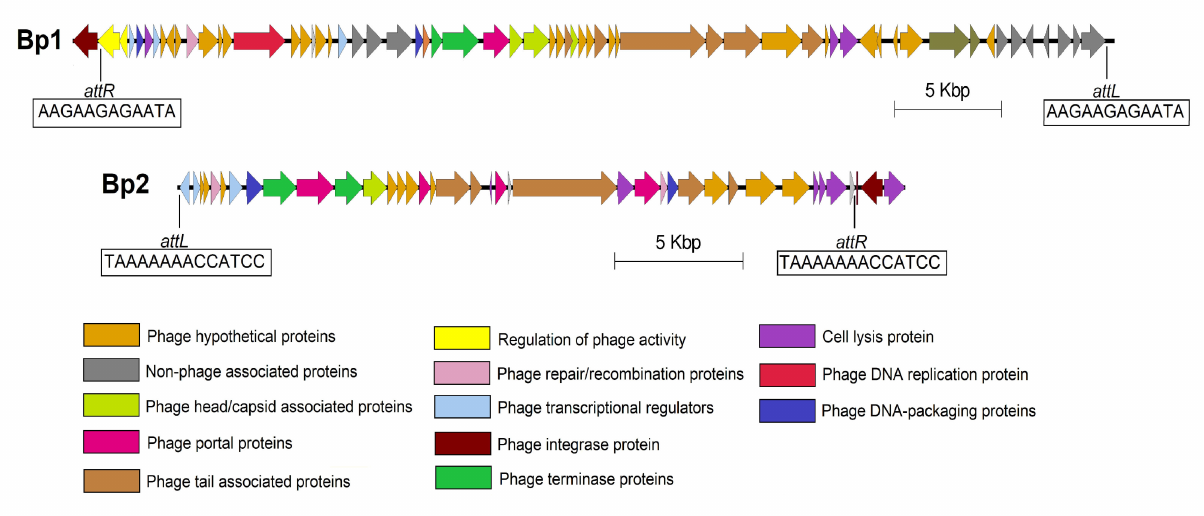
Figure 5. Phage regions of B. pumilus 3-19. The colors displayed basic phage and non-phage- associated